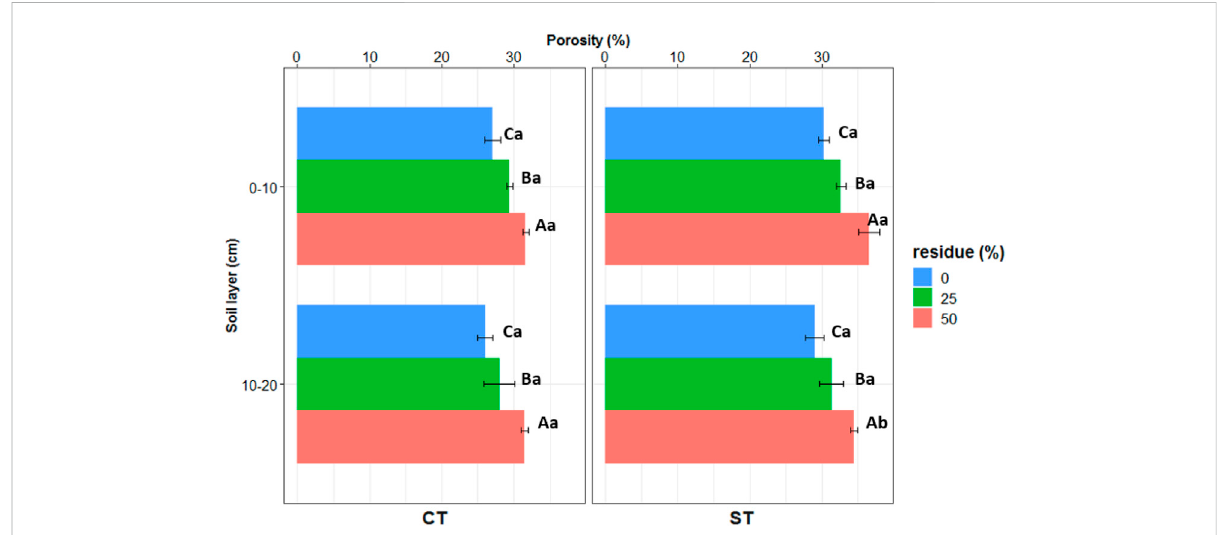
FIGURE 6 Effect of tillage and crop establishment (TCE) techniques and residue management (R) options on soil porosity at 0 – 10 and 10 – 20 cm pro fi le depths. For treatment, details refer to Table 2. Different upper-case lettersrepresent signi fi cant intragroup statistical difference at p ≤ 0.05; Different lower-case letters represent signi fi cant intergroup statistical difference at p ≤ 0.05; p values calculated by the ANOVA test and t -test.